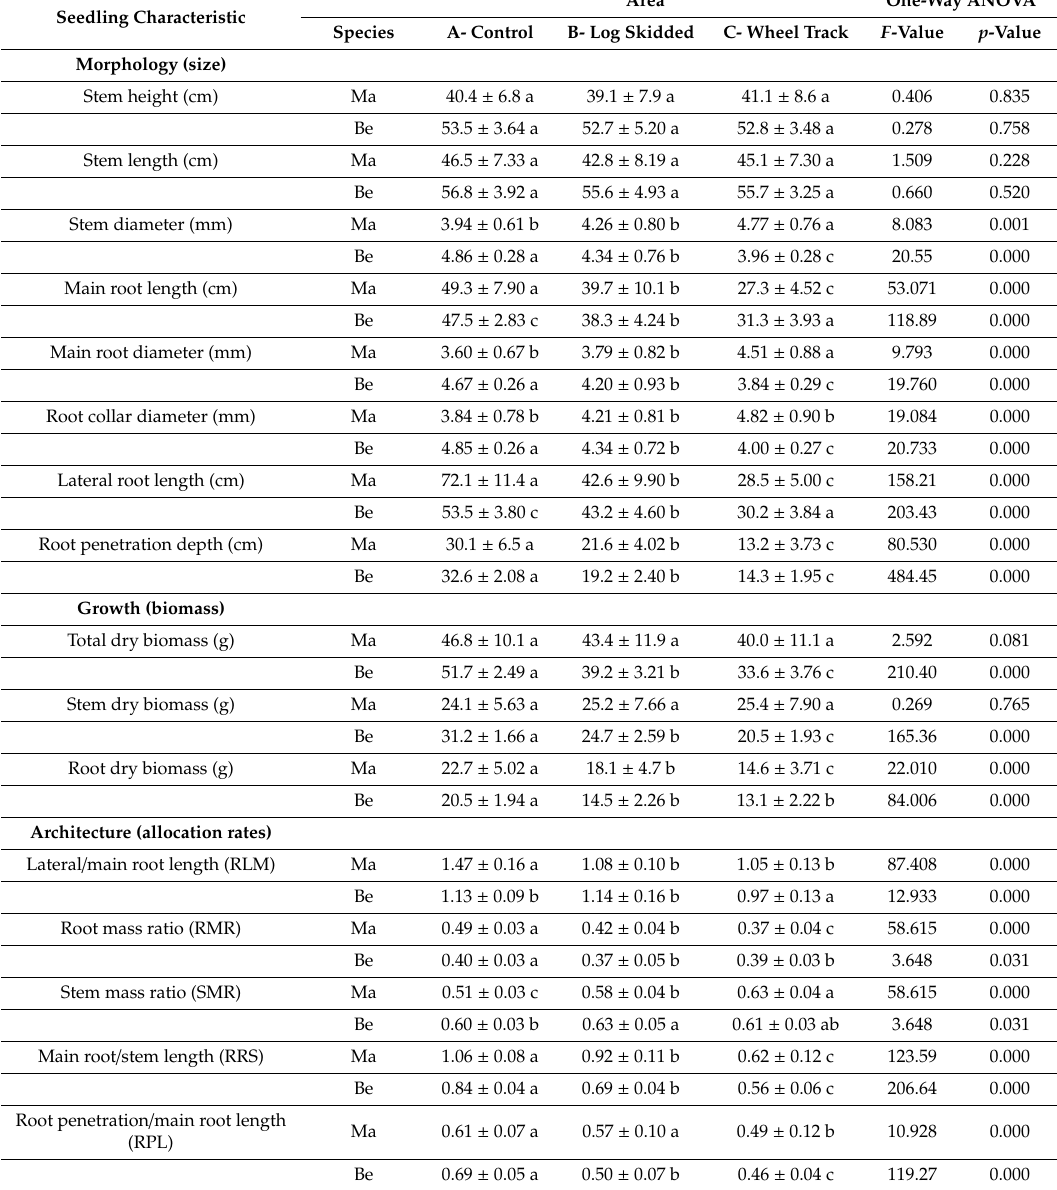
Table 2. E ff ect of soil compaction on maple (Ma) and beech (Be) seedling morphology, growth and architecture (Mean ± SD) in three areas and ANOVA and Duncan test